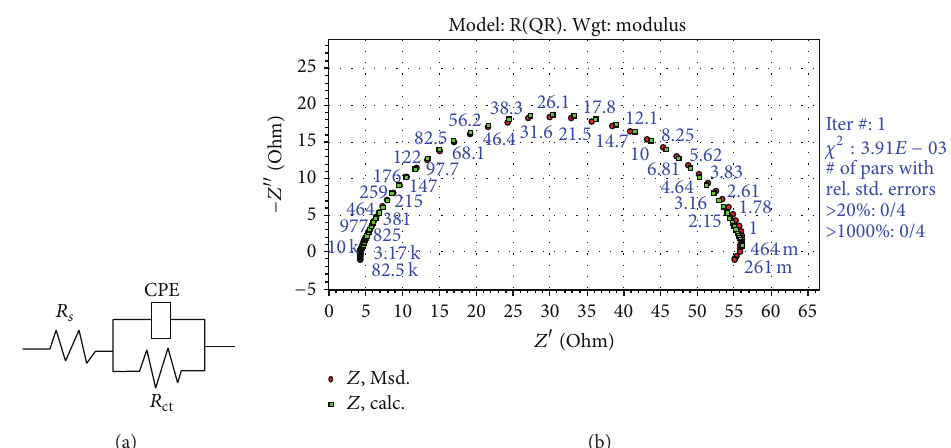
Figure 6: Equivalent circuit used to fit the experimental EIS data (a). EIS data obtained for the corrosion inhibition of mild steel in 1M HCl containing 0.8 mM HIBH at 40 ∘ C (b).